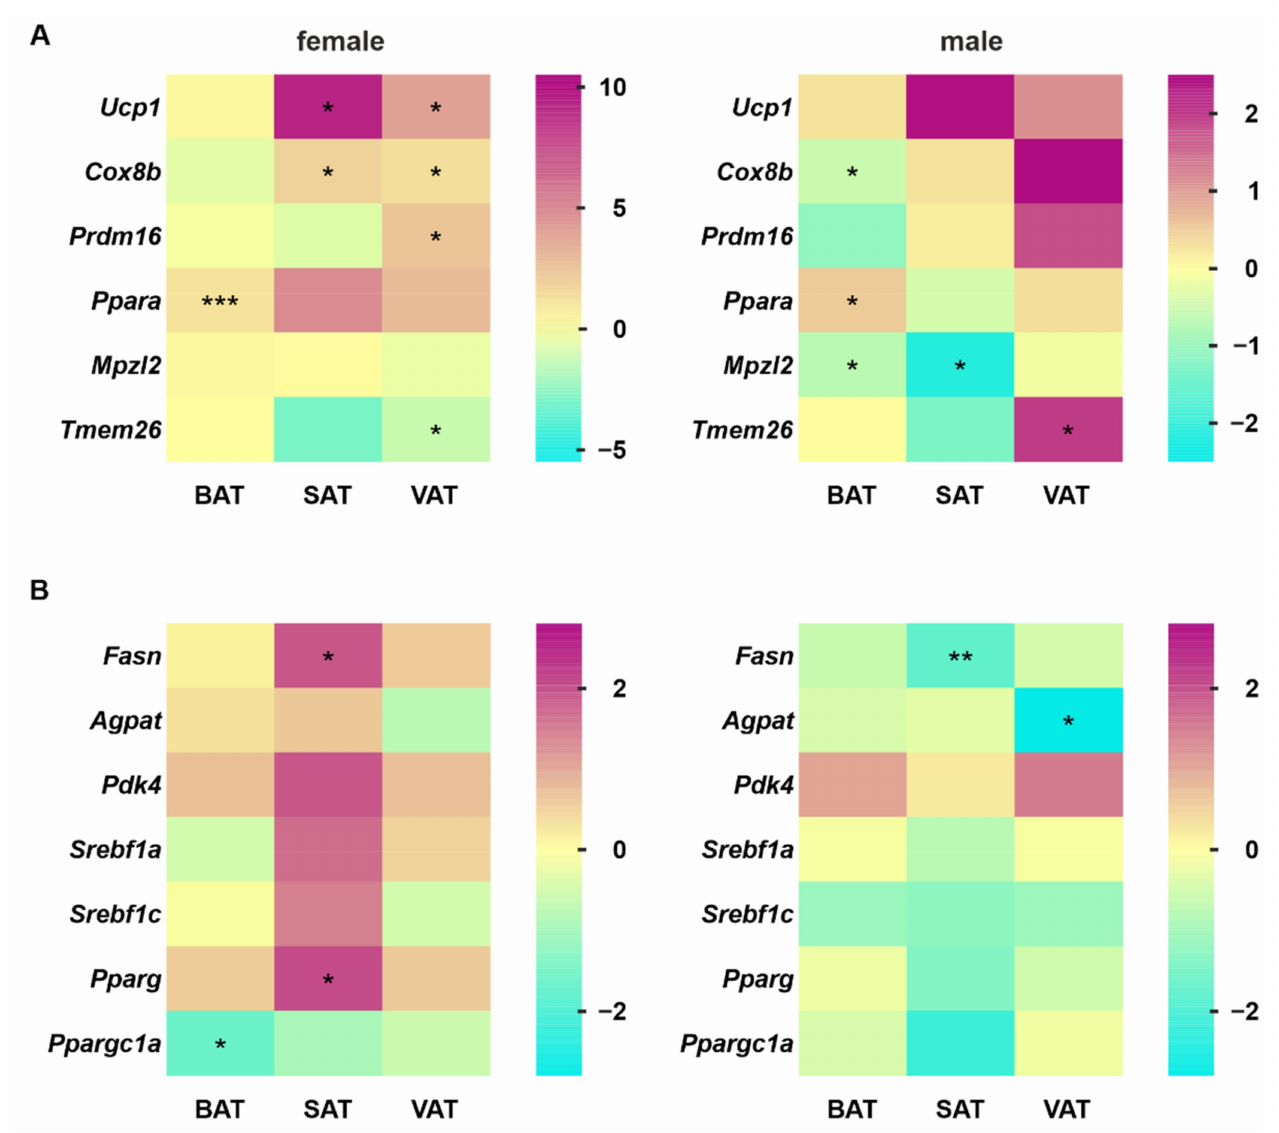
Figure 4. Lipid metabolism-related gene expression profiles. ( A ) Expression of browning and ( B ) lipid synthesis-related genes in female and male Hh adipose tissue was quantified by qPCR. Values are plotted as log 2 fold changes, n = 4–6, multiple unpaired t-tests with p -values * ≤ 0.05, ** ≤ 0.01, *** ≤ 0.001. Numeric values are available in Tables S6 and